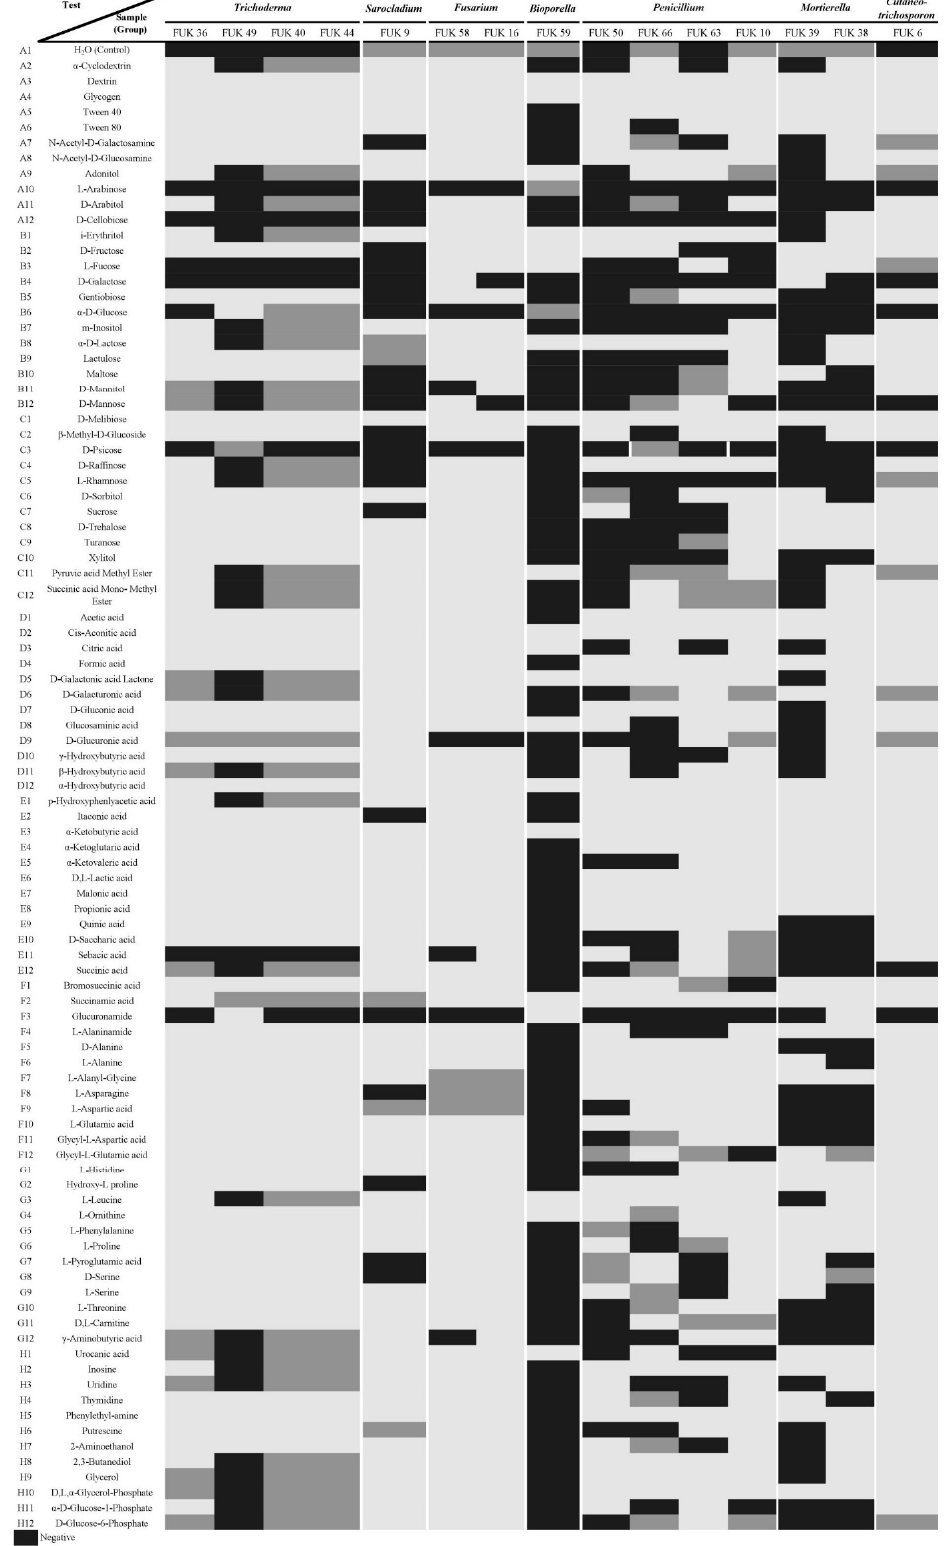
negative, ■ indicate those inconclusive results (INC), and ■ indicates the positive reaction from SFM isolates.